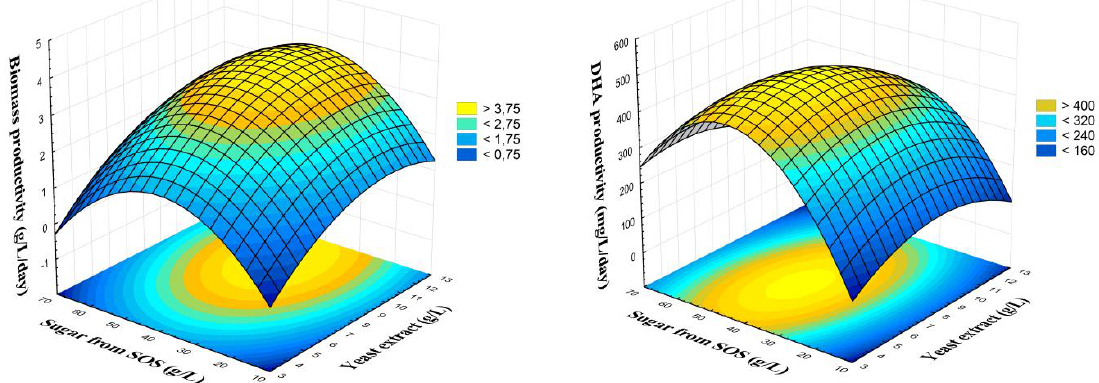
Figure 4. Surface plot for biomass productivity ( left ) and DHA productivity ( right ) using central composite design.